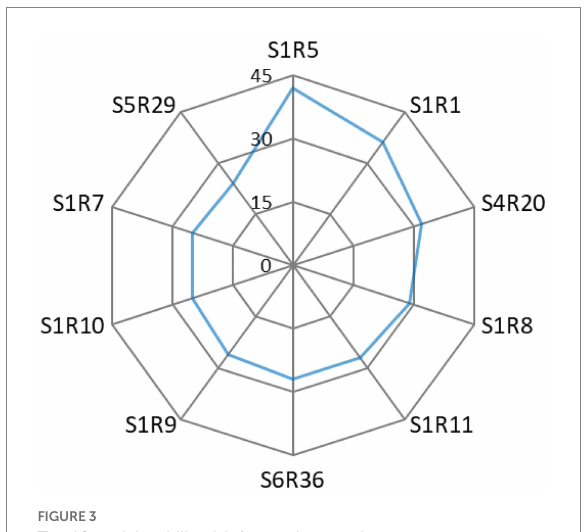
FIGURE 3 Top 10 social stability risk factors by